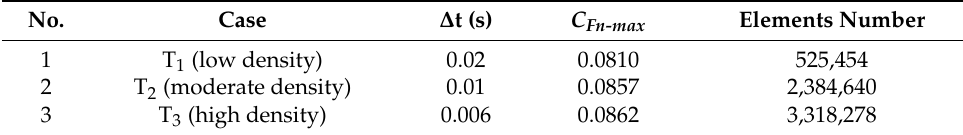
Figure 4. Detail view of the unstructured mesh around a cylinder periphery: ( a ) T1, ( b ) T2, ( c ) T3. Table 1. The cases of grid-size independence test, ƞ 0 /H = 0.0575.